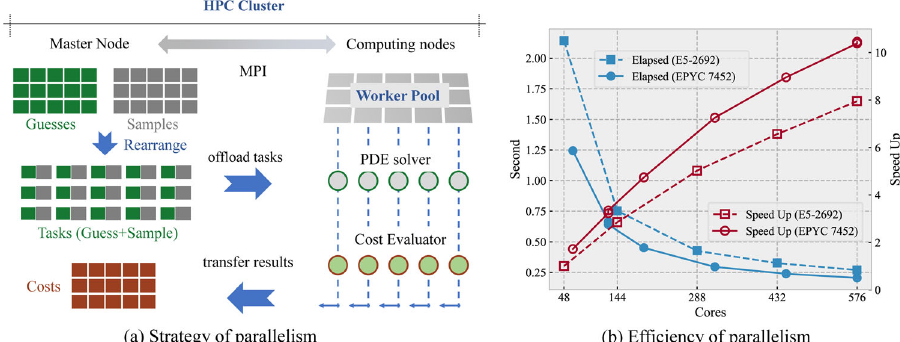
Fig. 8 Parallelism scheme of the cost evaluation kernel. a Schematic illustration of the parallelism mode for evaluating the cost of multiple guesses over large dataset with the support of MPI and HPC; b Parallelism ef fi ciency of the cost evaluator with parallelism for a single batch compared between 2 × 12 Intel Xeon CPU E5-2692 v2 @ 2.20 GHz and 2 × 32 AMD EPYC 7452 @2.35 GHz, where 136 diffusion couples are consumed in a single batch using1 MPI task per